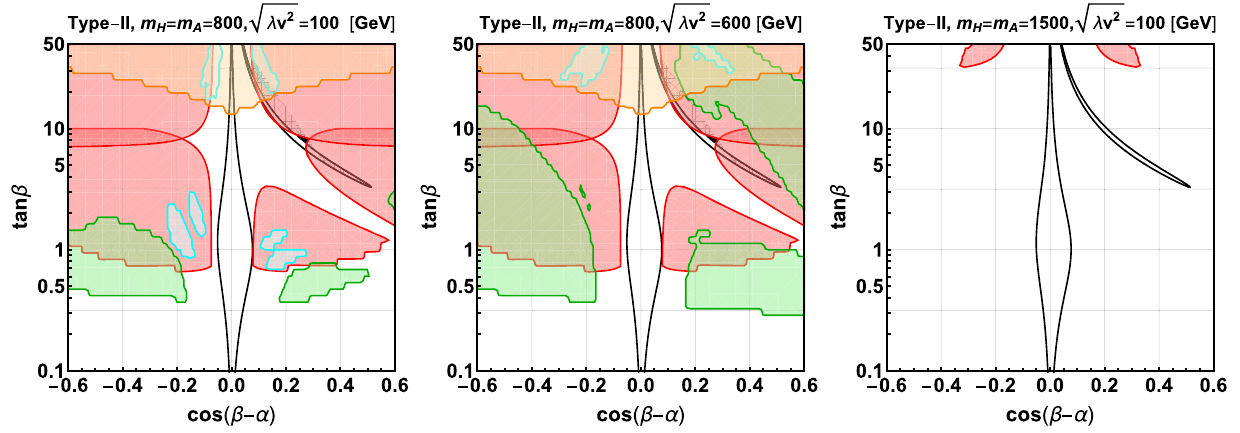
(cid:7) √ λv 2 ≡ ( m 2 − m 2 / s β c β ) = 100 middle), 1500 GeV (right) and H 12 GeV (left and right), 600 GeV (middle). The current precision mea- surements results are shown by solid lines. Generally the central region between the two lines around cos (β − α) = 0 are allowed except for the “arm” of Type-II, the wrong-sign Yukawa region as discussed detailed in Fig.